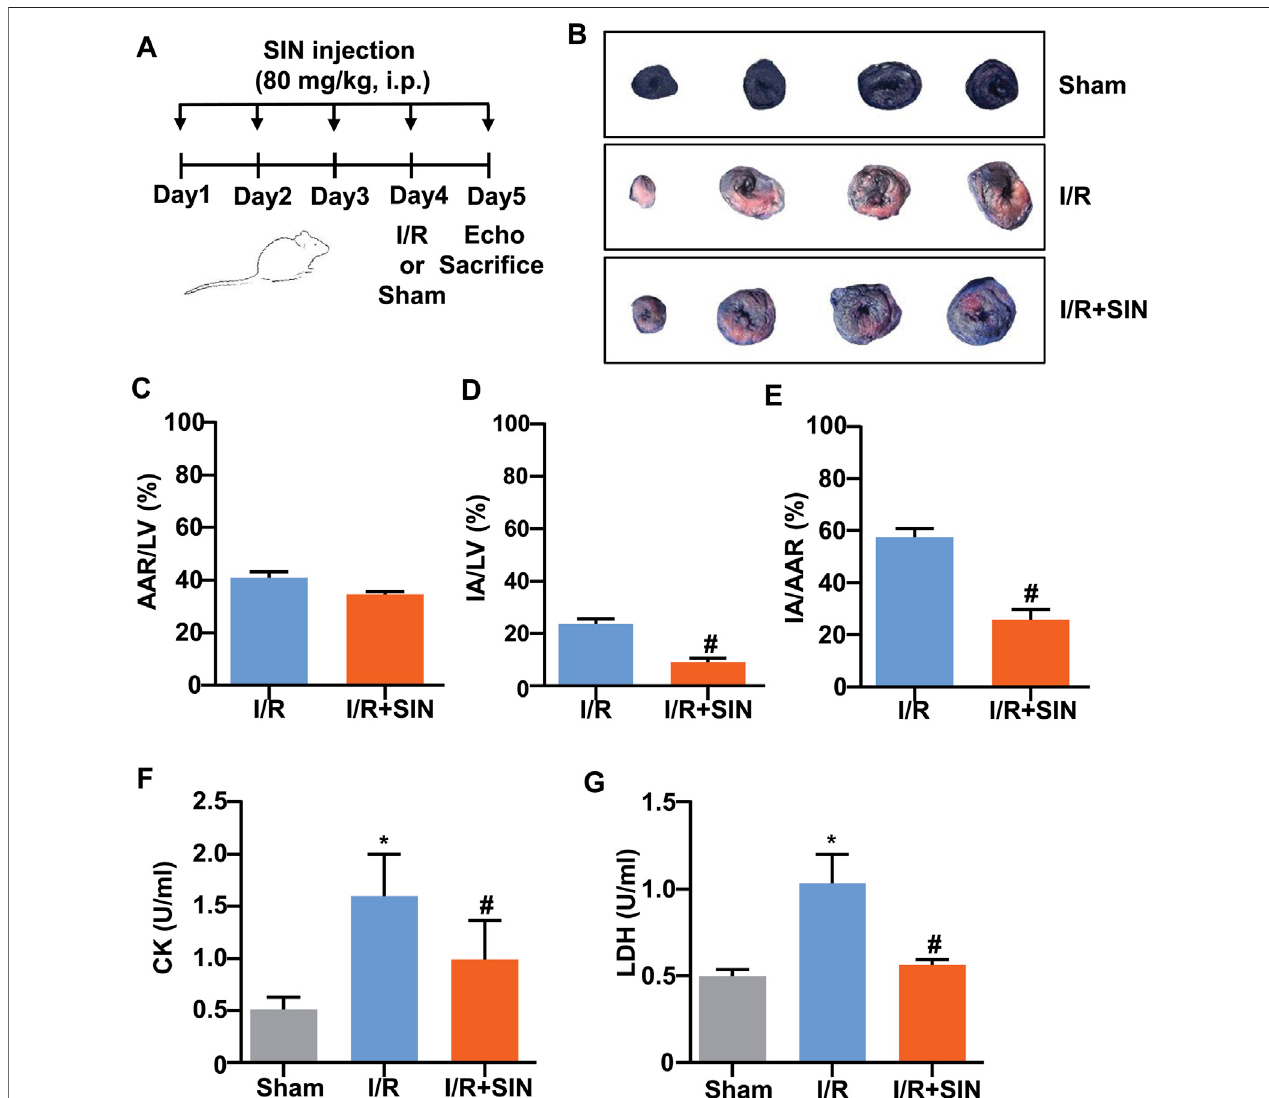
FIGURE 1 | Effect of SIN on myocardial damage in MIRI mice. (A) Timeline for the experimental showing drug administration, ischemia-reperfusion surgery, and killingof themice. (B) Representative photograph ofEvans blue/TTC double-staining inthe heart of mice treated with or without SIN. The non-ischemic area, which was not at risk, was stained blue, whereas the viable myocardium was stained red and the infarct area was stained white. The area at risk was the sum of the white and red regions. (C – E) Quantitative analysis of Evans blue/TTC double staining show that pretreatment with SIN signi fi cantly decreased the ratio of infarct area to left ventricle (IA/LV) (C, n = 5) and area at risk (IA/AAR) (E, n = 5) compared with the MIRI group (# p < 0.05 vs. I/R), and no signi fi cant differences in area at risk normalized to left ventricle (AAR/LV) (D, n = 5) were observed between the two groups. (F,G) Quantitative analysis show that pretreatment with SIN signi fi cantly prevented the MIRI- induced increase in serum CK (F, n = 5) and LDH (G, n = 5) levels in mice (* p < 0.05 vs. sham; # p < 0.05 vs. I/R). Data are shown as means ± SEM.